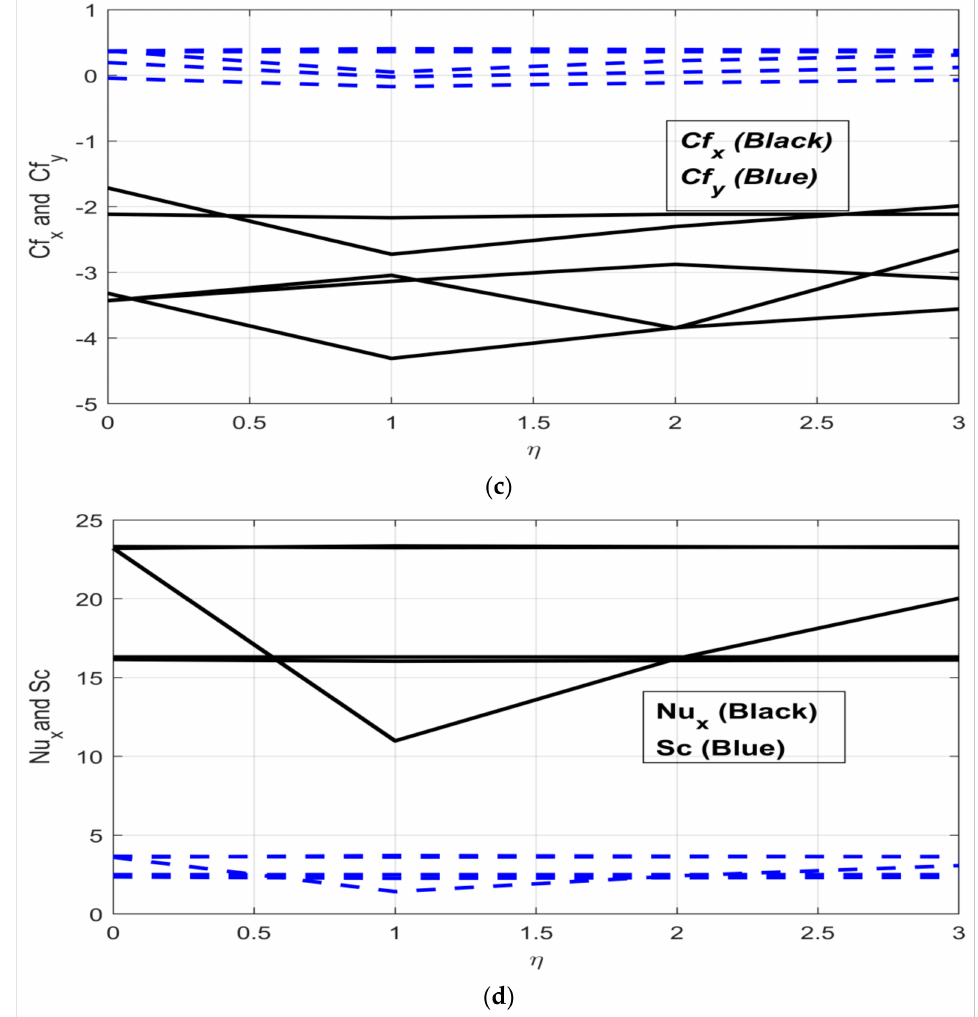
Figure 6. ( a ) Influence of the unsteadiness parameter s on the concentration profile ϕ ( η ) . ( b ) Influence of radiation R a on ϕ ( η ) . ( c ) Skin coefficients in x and y directions. ( d ) Heat and mass coefficients ( Nu x , Sc